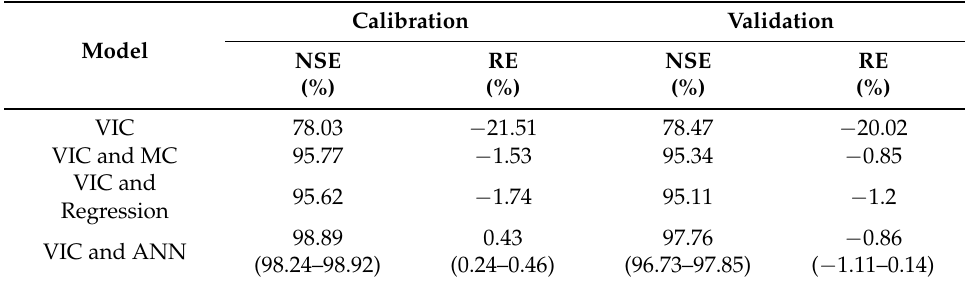
Figure 8. Daily prediction interval, ensemble mean, observed values and VIC model ‐ simulated values corresponding to Subbasin 2. Table 3. Traditional VIC model, VIC and ANN ensemble mean model, VIC and linear regression model and VIC and MC model performance during calibration and validation. MC, Muskingum ‐ Cunge.